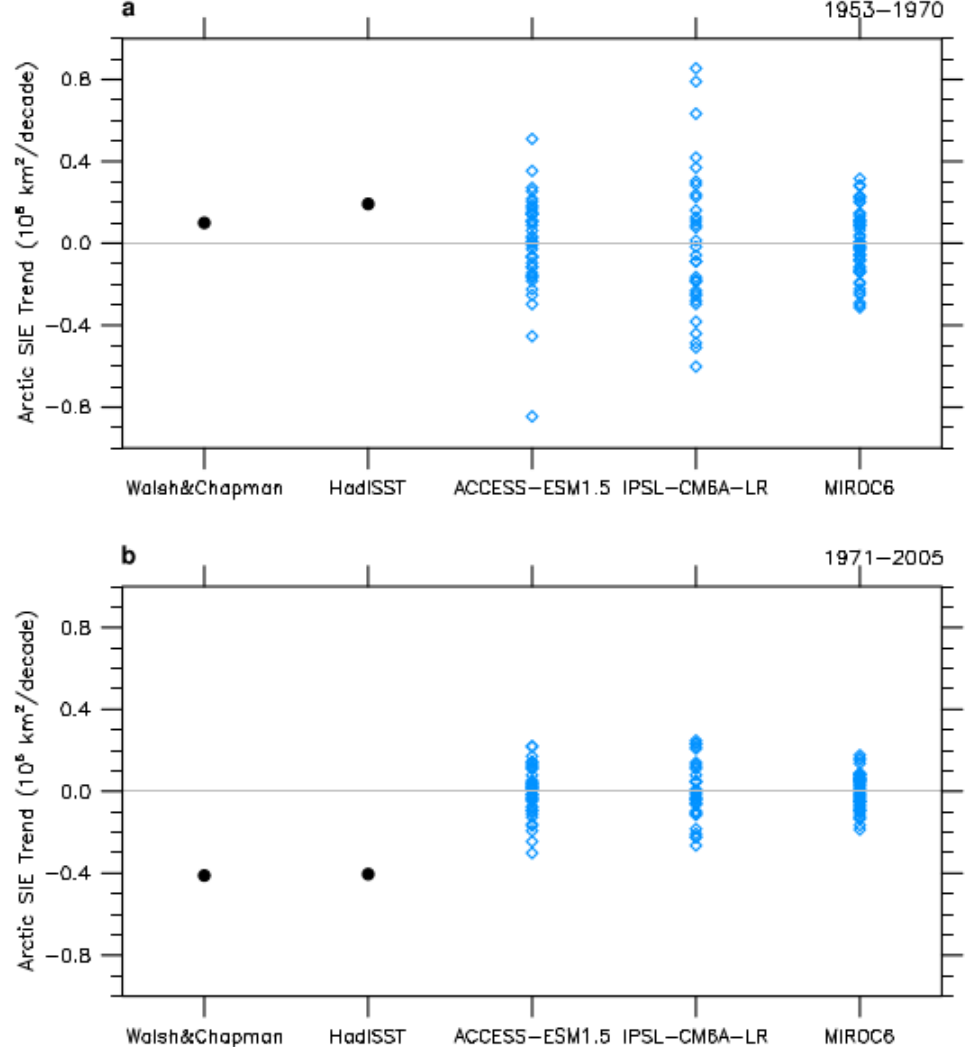
Figure 10. ( a ) Linear trends of annual mean Arctic sea ice extents from Walsh and Chapman and HadISST data (black) and ensemble members of ACCESS1-ESM1.5, IPSL-CM6A-LR and MIROC6 (blue) over 1953–1970. For each model, the ensemble mean of the trend is removed. ( b ) Same as ( a ) but for trends over